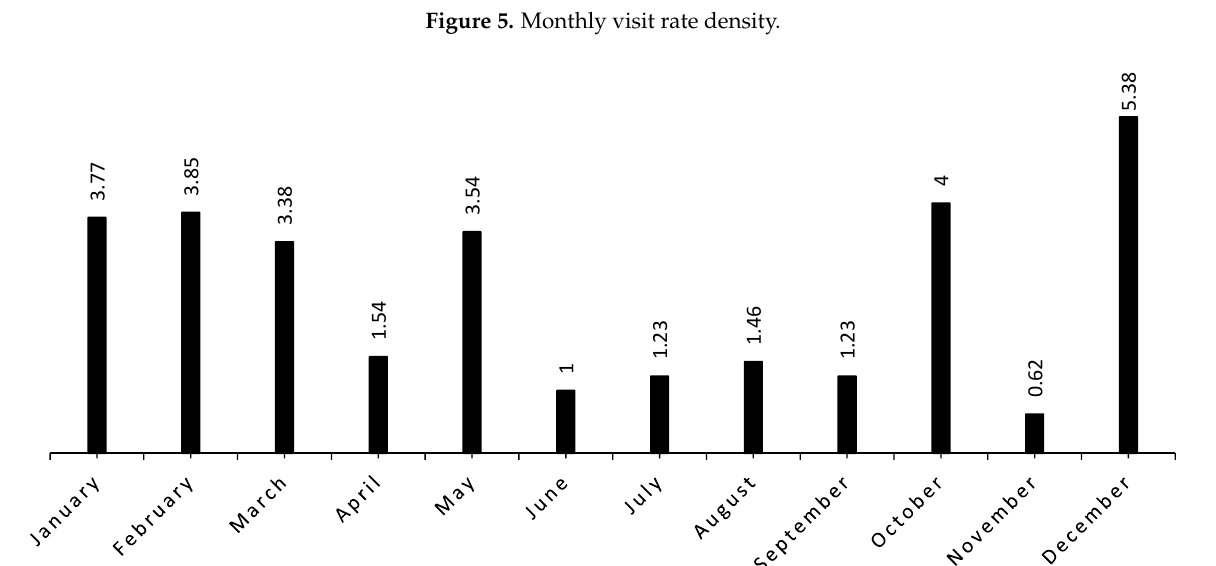
Figure 6. Monthly average visit rate per photo-user days per month.